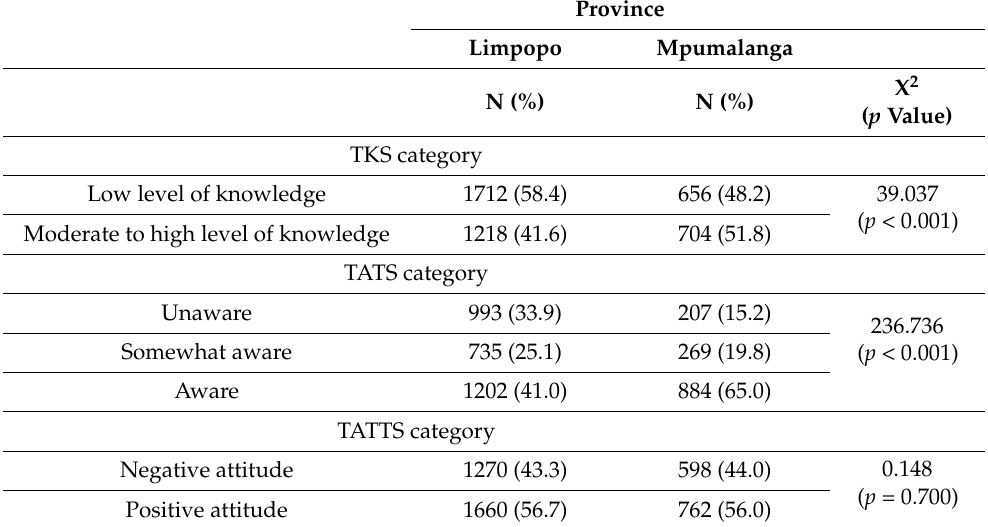
Table 3. Community members’ knowledge, awareness, and attitude scores were